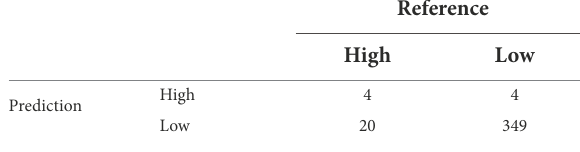
TABLE 3 Confusion matrix of multinomial outcome class for FUM- GBM analysis to validate reference (testing data set) actual data for toxin levels and the predicted results using the